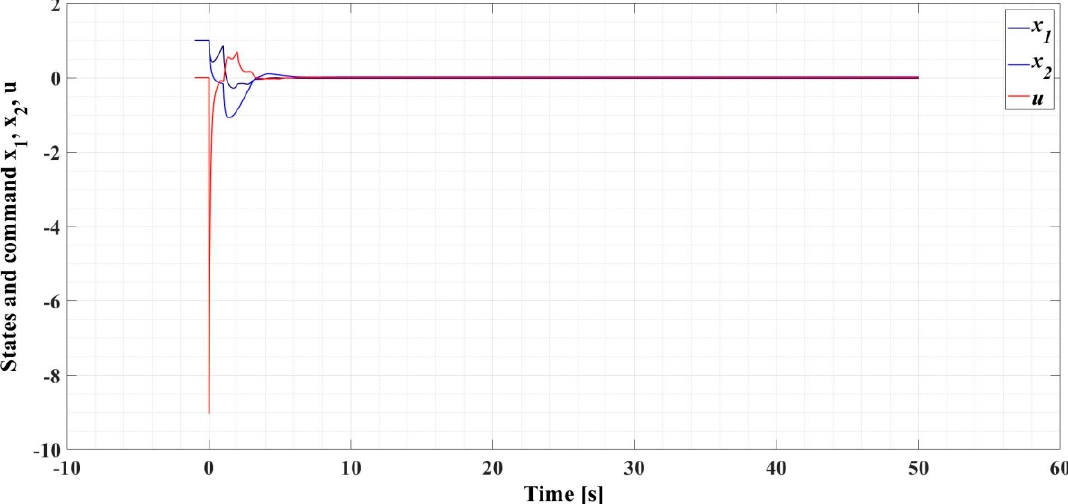
Figure 4. Evolution of the states without input saturation.